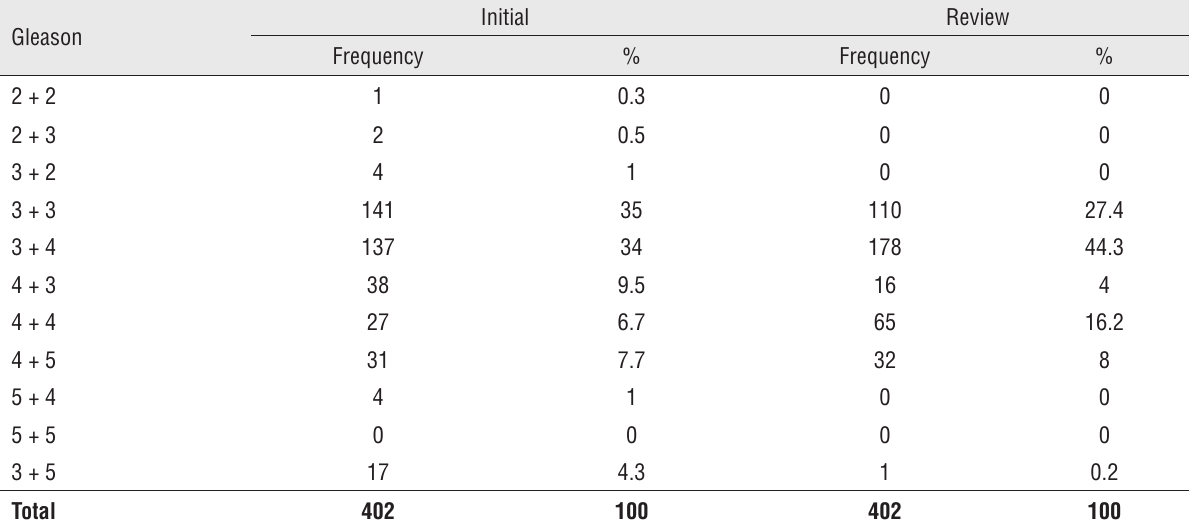
patients.Table 2 - Initial and post - review GS of all